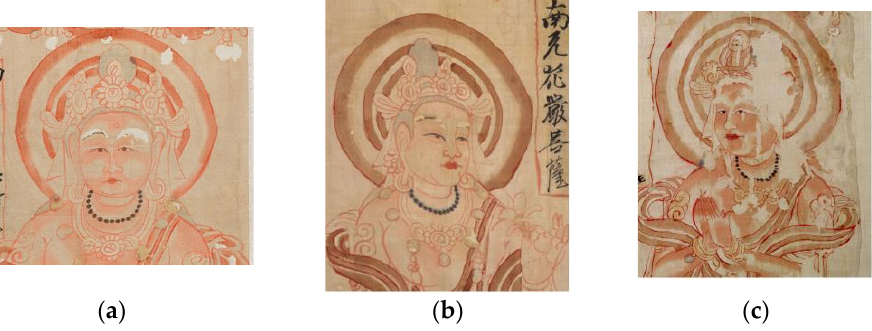
Figure 5. Comparison of the painting styles: ( a ) details of Bon 4025 (Figure 4); ( b ) details of Stein Painting 196 (Figure 3); and ( c ) details of Stein Painting 216 (Figure 1).